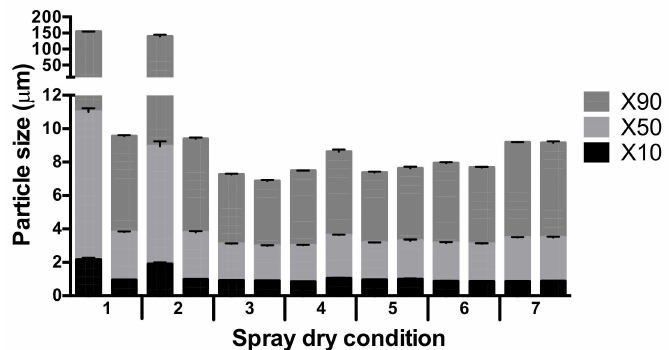
Figure 1. The primary particle size distributions resulting from the seven spray-drying conditions (see Table 1) for the isoniazid formulation with 5% L-leucine w / w . The duplicate samples are shown next to each other, for each sample n = 3, average ± standard deviation (SD) is